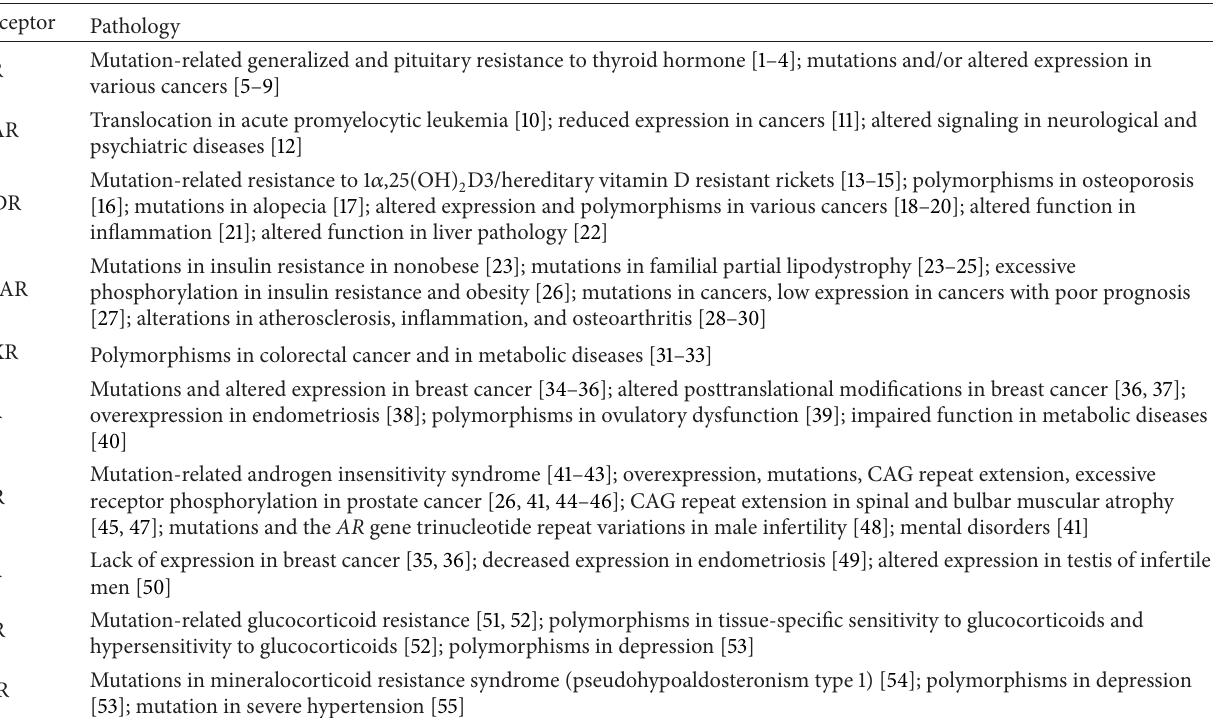
Table 2: Selected human pathologies associated with hormone